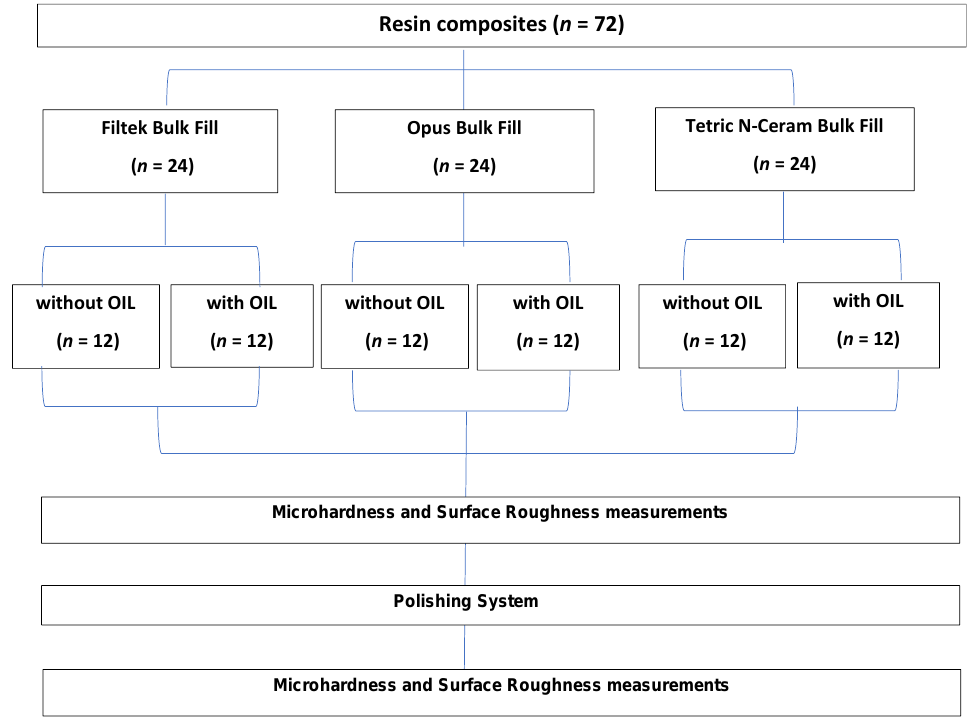
Figure 1. Random distribution of groups according to resin composite type, glycerin use, and polishing type.